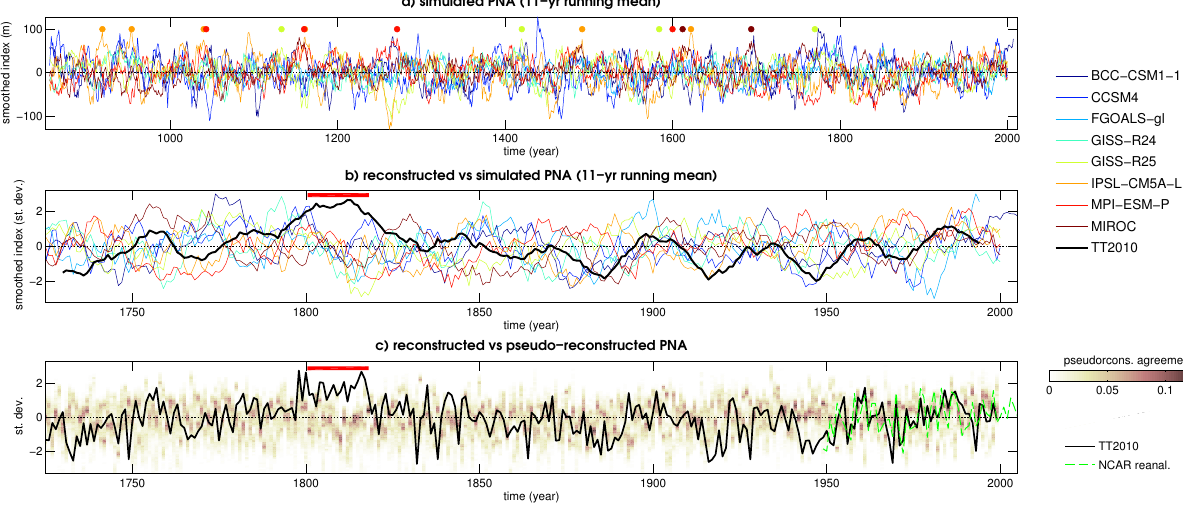
Figure 4. Simulated, reconstructed and pseudo-reconstructed evolutions of the winter (DJF) PNA index. (a) smoothed PNA time series from the simulations for the whole last millennium; (b) comparison between smoothed and normalized (over the period 1725–1999) PNA time series from the simulations and the TT2010 reconstruction; (c) comparison between normalized (over the period 1950–1999) pseudo- reconstructions (shown as agreement between pseudo-reconstructions from all the simulations) and the TT2010 reconstruction. Smoothing in panels (a) and (b) was performed with an 11-year moving average. Dots in panel (a) individuate, for each simulation, occurrences of prolonged periods of positive PNA (defined as periods where the normalized smoothed index is above 1 for at least 15 consecutive years). The red bar in panels (b) and (c) highlights the approximate period of the simulations-reconstruction discrepancy.